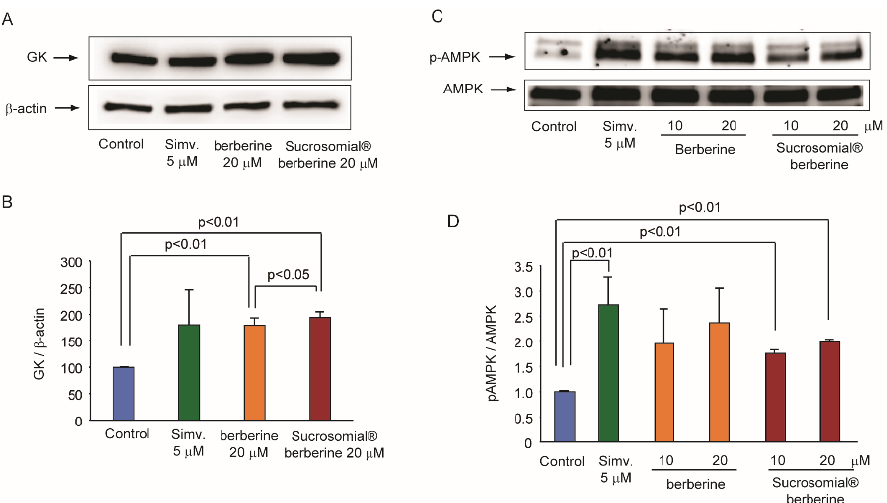
Figure 2. Effect of Sucrosomial ® berberine on GK expression and AMPK phosphorylation ( B ) in Huh7 cell line. Cells were incubated in DMEM containing 25 mM glucose with indicated concentrations of berberine for 24 h. After this period, total cellular proteins were extracted for the analysis. β‐ actin was used as loading control. ( A ) Western Blot of GK intracellular expression upon treatments; ( B ) Densitometric analysis of GK intracellular expression relative to β‐ actin; ( C ) Western Blot of pAMPK intracellular expression upon treatments; ( D ) Densitometric analysis of pAMPK intracellular expression relative to AMPK. DMEM: Dulbecco’s modified Eagle Medium; GK: glucokinase; AMPK: 5 (cid:48) adenosine monophosphate-activated protein kinase; pAMPK: phospo-AMPK. DMEM, GK,